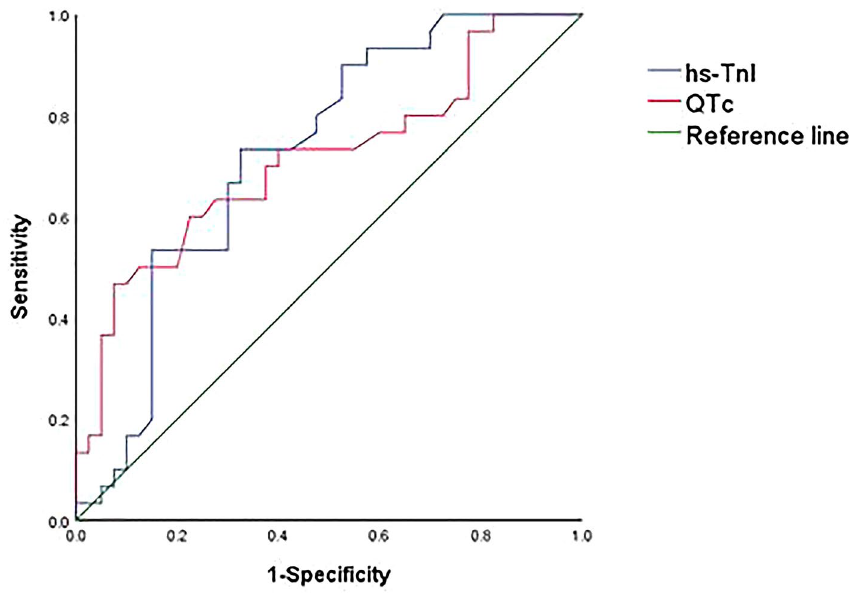
Figure 3. ROC curves of hs-TnI and QTc for the diagnosis of